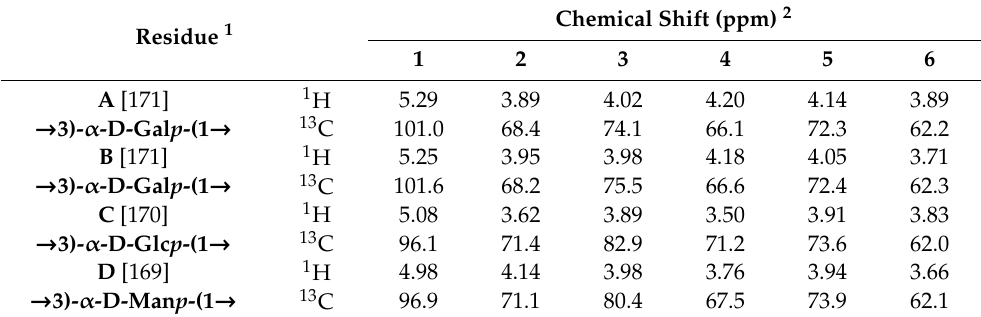
Table 1. 1 H and 13 C chemical shift assignments of the Epol H111-INS in 0.3 M